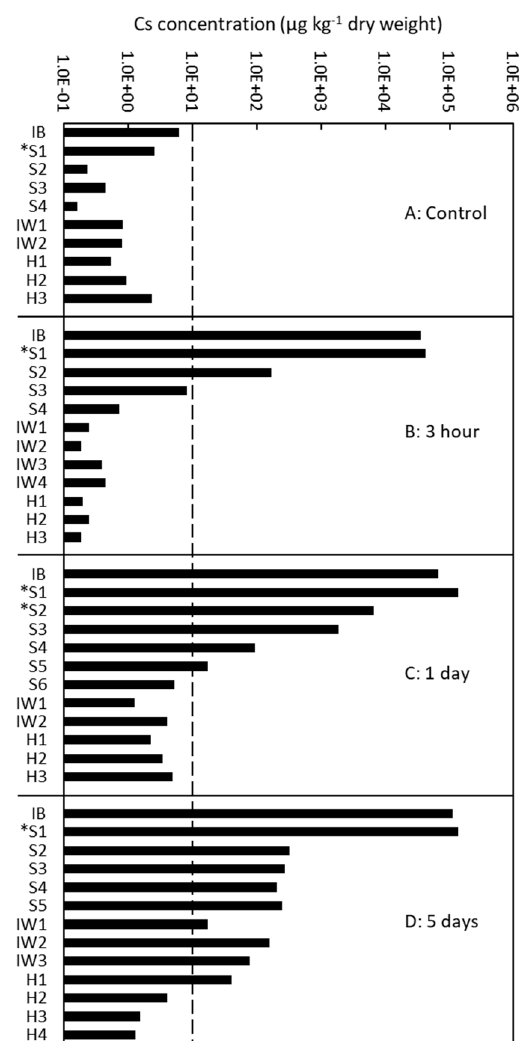
Figure 5. Quantitative analysis of the radial distribution of cesium (Cs) in the xylem of Japanese cedar ( Cryptomeria japonica ) trees using inductively coupled plasma mass spectrometry (ICP-MS) after ( A ) no injection (control); ( B ) 3 h of injection; ( C ) 1 day of injection; and ( D ) 5 days of injection in Tree 137. IB, inner bark; S1–S6, sapwood from the outer (S1) to inner (S6) parts; S with asterisk, sapwood with red coloration stained by acid fuchsin; IW1–4, intermediate wood from the outer (IW1) to inner (IW4) parts; and HW1–4, heartwood from the outer (H1) to inner (H4) parts.